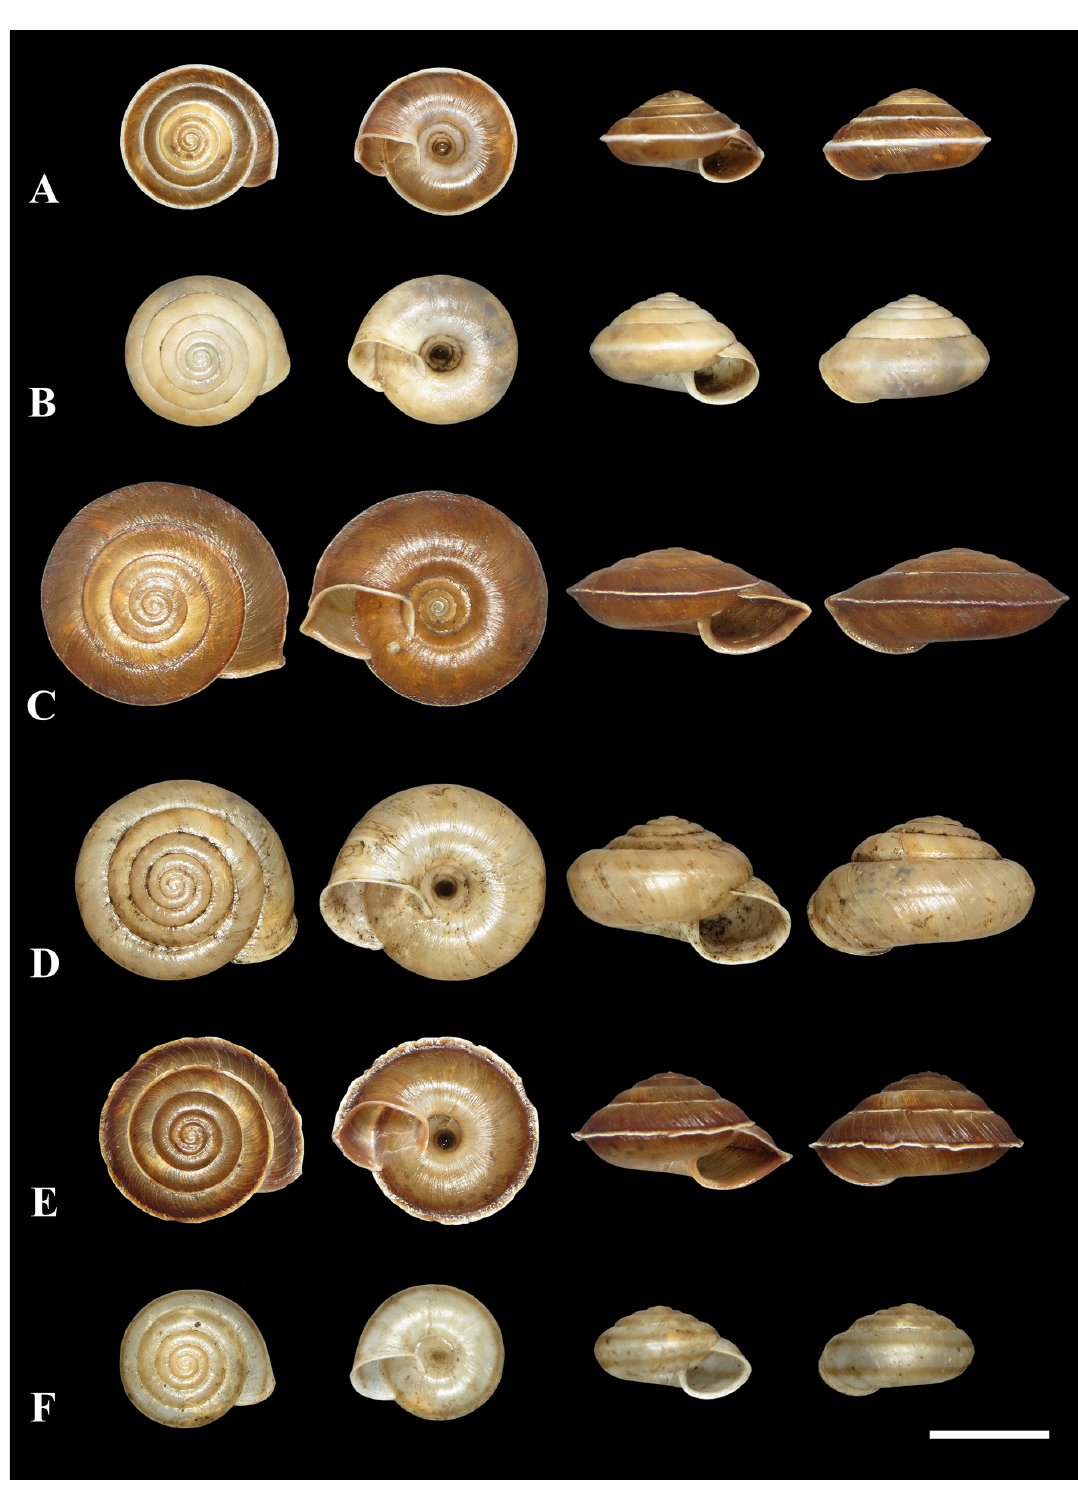
Fig. 3. External shell morphology of Landouria spp. from northeastern Thailand. A . Landouria circinata sp. nov., holotype (NHMSU-00023). B . L. tuberculata sp. nov., holotype (NHMSU-00025). C . L. trochomorphoides sp. nov., holotype (NHMSU-00027). D . L. chloritoides sp. nov., holotype (NHMSU-00029). E . L. elegans sp. nov., holotype (NHMSU-00032). F . L. diplogramma (Möllendorff, 1902) comb. nov. (NHMSU-00034). Scale bar = 10